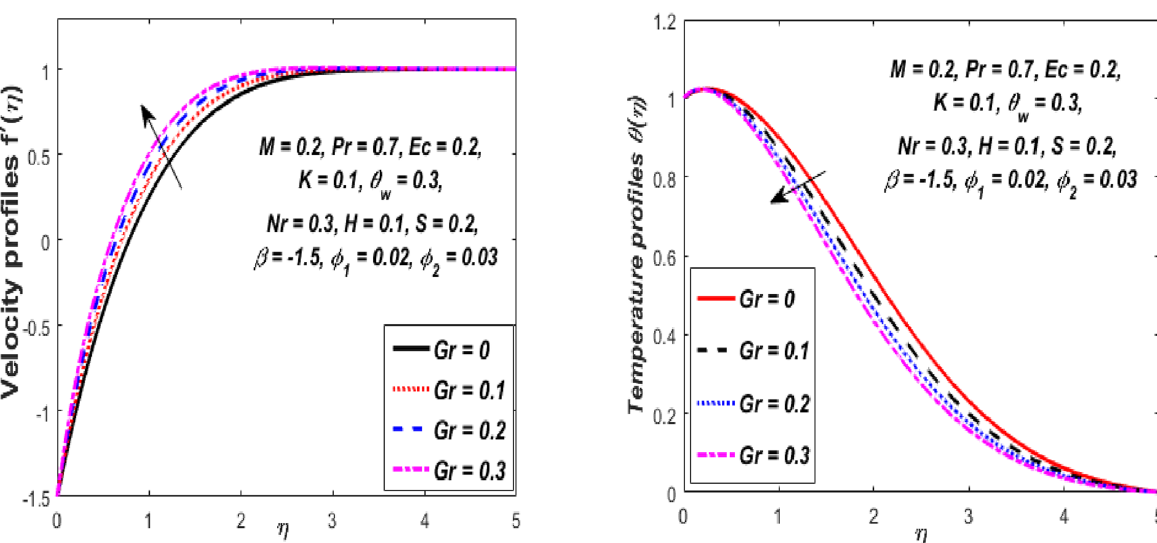
Figure 6. Influence of Gr on velocity f ′ (η) and temperature θ(η)